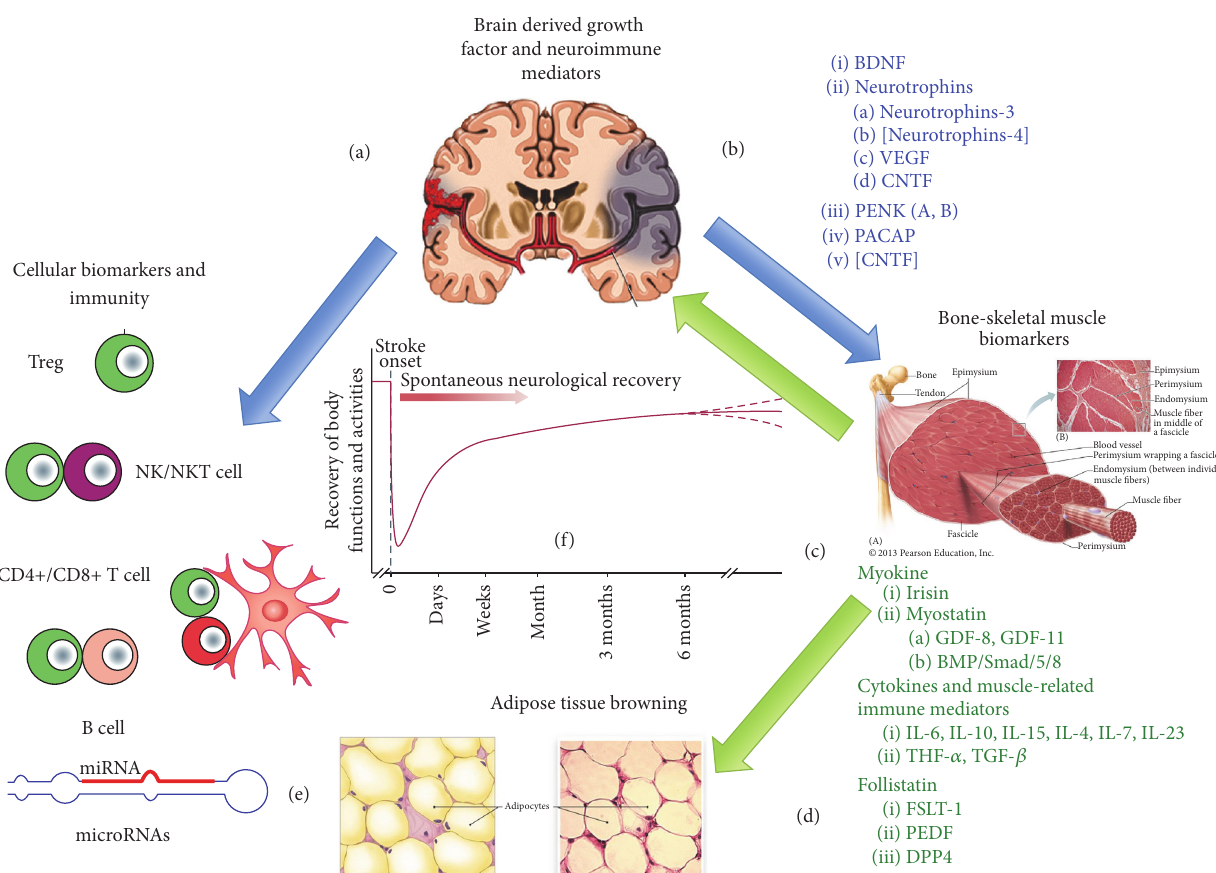
Figure 1: Cartoon showing the relationship between brain, muscle, and the immune system during stroke onset and stroke recovery, in order to highlight possible biomarkers of these events, as described in the text. Damaged brain, either following ischemic or hemorrhagic stroke, produces a panoply of different biomolecules, mainly BDNF or other neuromodulators, which link brain function with the immune system (a) and skeletal muscle (b). The first releases cytokines and cellular markers and the second one myokines, many of which interact with BDNF (c). Many of these myokines modulate the activity of other tissues such as vascular tissue (endothelia), bone, and adipose tissue. Irisin is a known “browning stimulator” (d). Downstream regulators of these mechanisms are represented by newly discovered miRNAs (e). The relationship between the activity of a defined biomarker (dose/time in plasma) and stroke recovery can be plotted in a time course curve as exemplified in